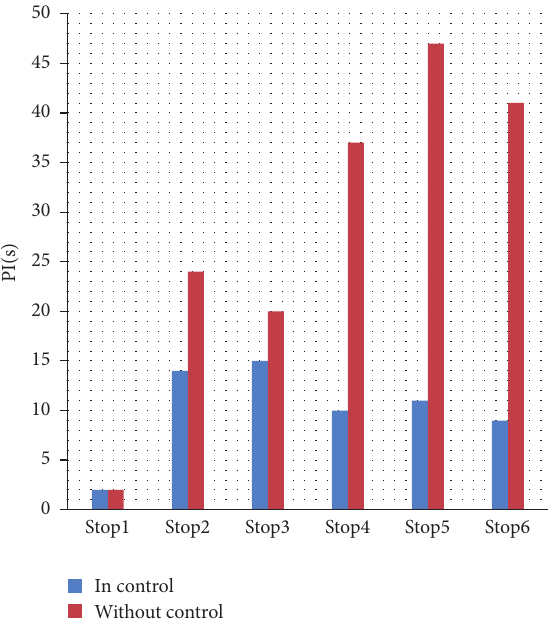
bus received five speed adaptation messages but one of them failed to be implemented and the traffic signals were requested to change their timing plans four times but were only able to accommodate two such requests, yet the bus (pink lines) was able to run within 5 s to 15 s of the planned schedule despite these